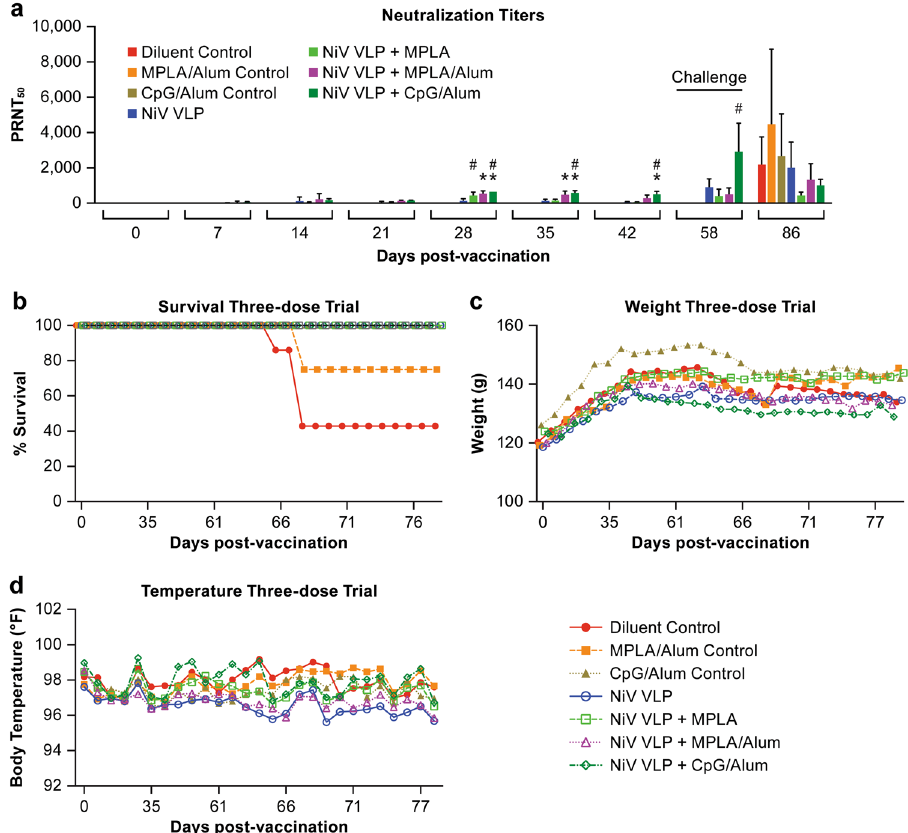
Fig. 2 Neutralizing antibody titers and survival following challenge in a three-dose vaccination regimen. a Serum collected from vaccinated animals was tested for the presence of neutralizing antibodies following vaccinations. The (*) indicates a group average statistically ( P < 0.01) greater than the diluent control for the same time point. The (#) indicates a group average statistically ( P < 0.01) greater than the day 0 sample for the vaccination group, b Survival, c Weight change and d temperature change following vaccination and after viral challenge at day 58. In b , c and d , each marker represents the mean for the group